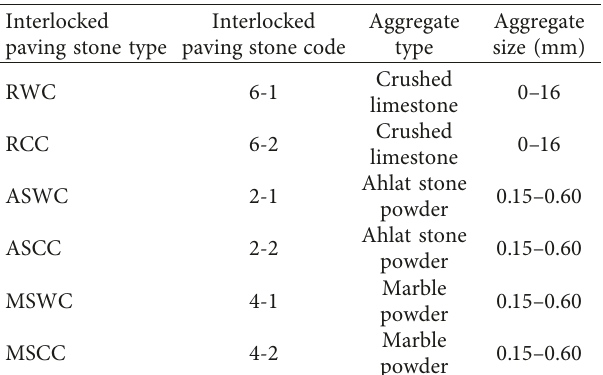
Table 3: Interlocked paving stone type, code, aggregate type, and size.